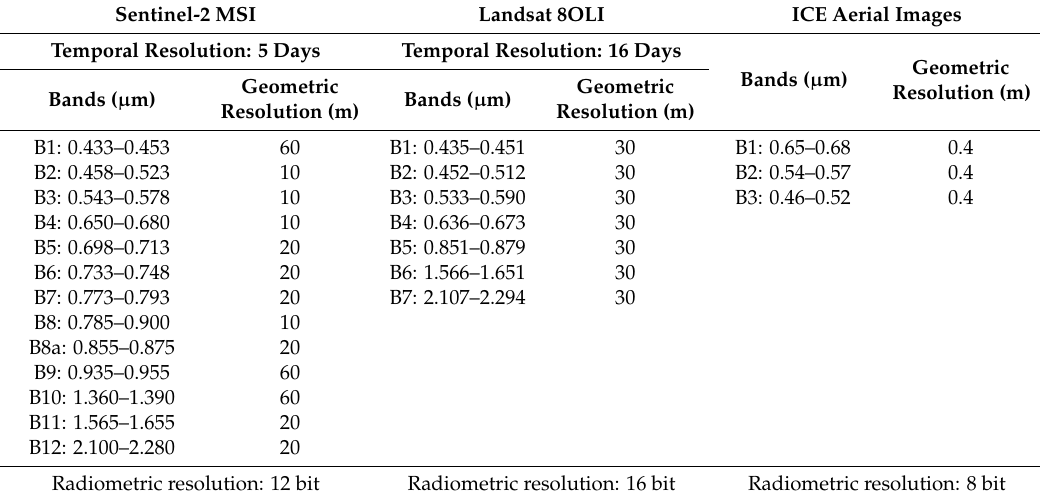
Table 2. Technical features of S2 and L8